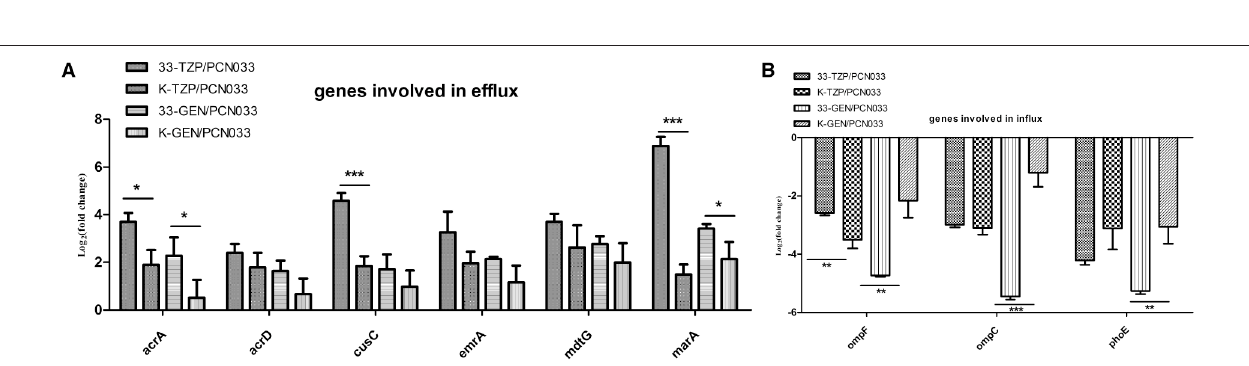
FIGURE 5 | Expression levels of genes involved in antibiotic efflux and influx during tazobactam and gentamycin treatments. (A) Expression of efflux genes, (B) expression of influx genes. Expression levels of the genes were compared with those of WT (PCN033). 33-TZP/PCN033 indicates the expression levels in PCN033 during tazobactam treatment compared with those in untreated PCN033; K-TZP/PCN033 indicates the expression levels in the 1 ppk mutant during untreated PCN033.K-GEN/PCN033 indicates the expression levels in the 1 ppk mutant during gentamycin treatment compared with those in untreated PCN033. *** p < 0.000, ** p < 0.01, * p < 0.05.